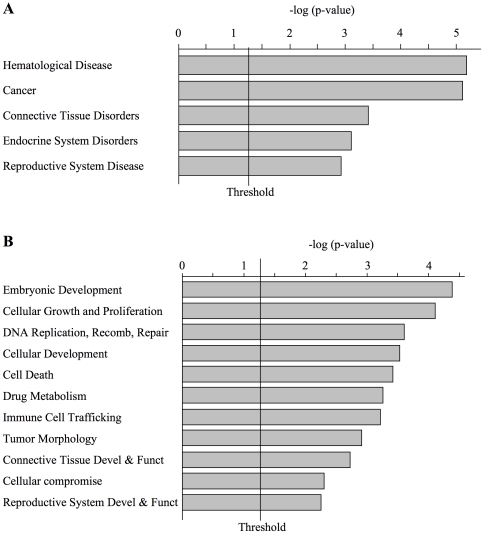
Functional analysis of AP2α target genes.Most prominent functional categories of diseases and pathological disorders (A), or of biological functions (B), associated with 272 potential AP2αtarget genes (PBM binding values, p<0.05). The threshold significance line indicates a value of −log(p-value) greater than 1.25.